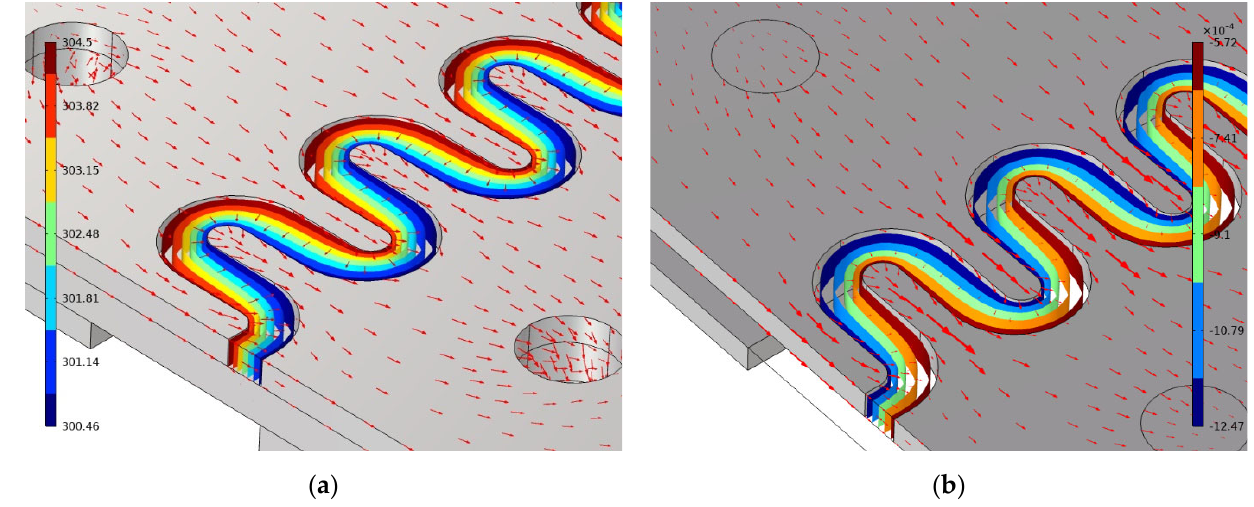
Figure 3. ( a ) Temperature and heat flux and ( b ) voltage and electrical field in the TE element.